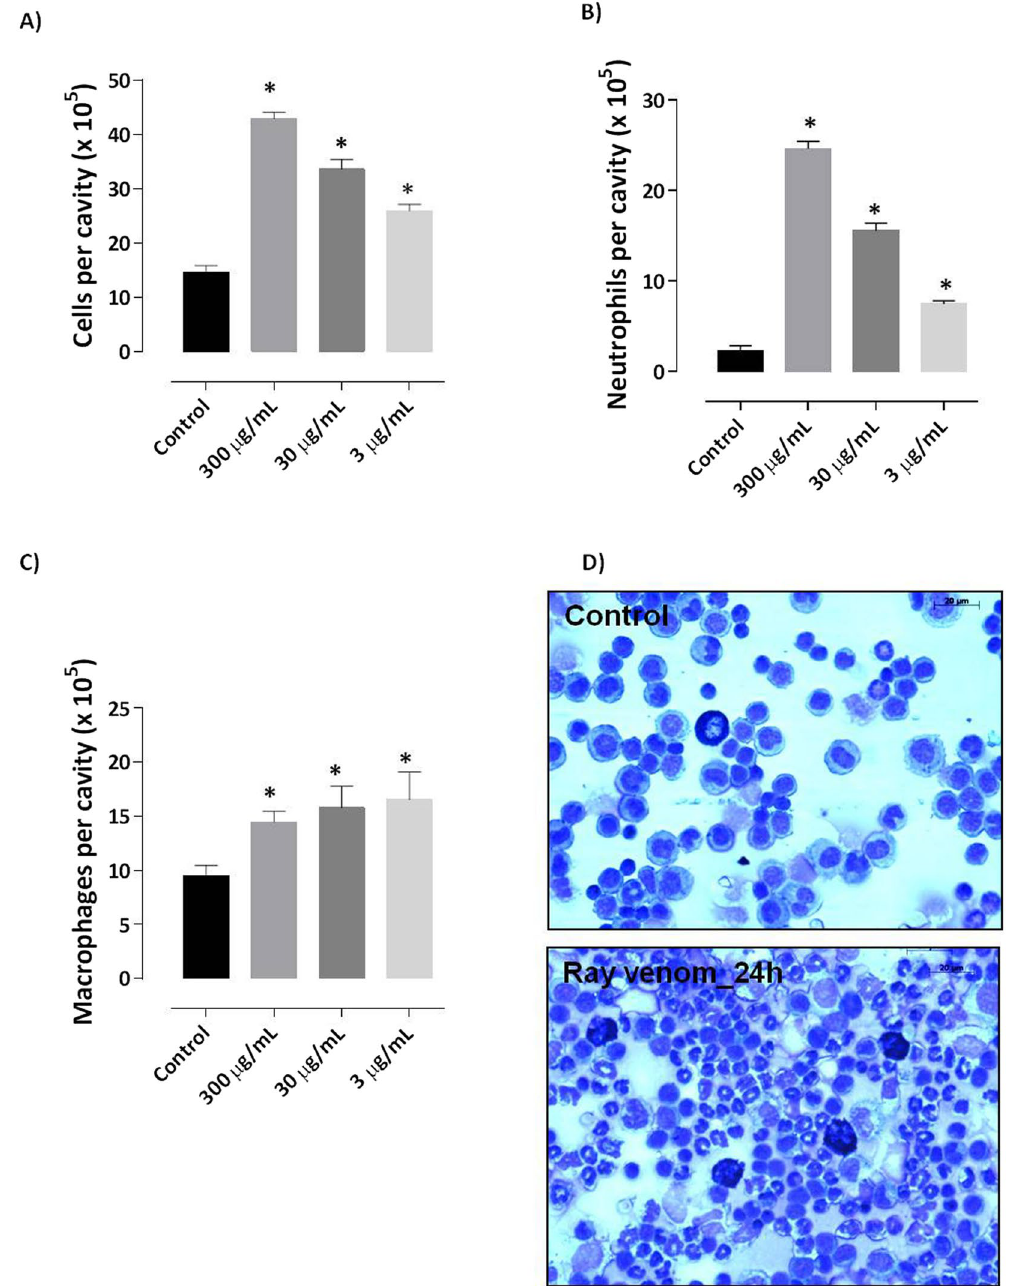
Figure 1. Potamotrygon cf. henlei ray venom induces neutrophilia in a murine model of peritonitis. Two hours after i.p. injection of 500 μ l of stingray venom at different concentrations (300, 30, or 3 μ g/ml), Swiss mice ( n = 4–7 per group) were killed and peritoneal cavities washed for cell suspension collection. Total ( A ), neutrophils ( B ), and macrophages ( C ) cells were counted. Mice injected with only saline constituted the control-group. Analysis of peritoneal exudates of ray venom-injected mice demonstrate the peak of neutrophils at 24 h ( D ). Results represent mean ± SEM. Pooled results of two independent experiments. * p < 0.05 compared with the